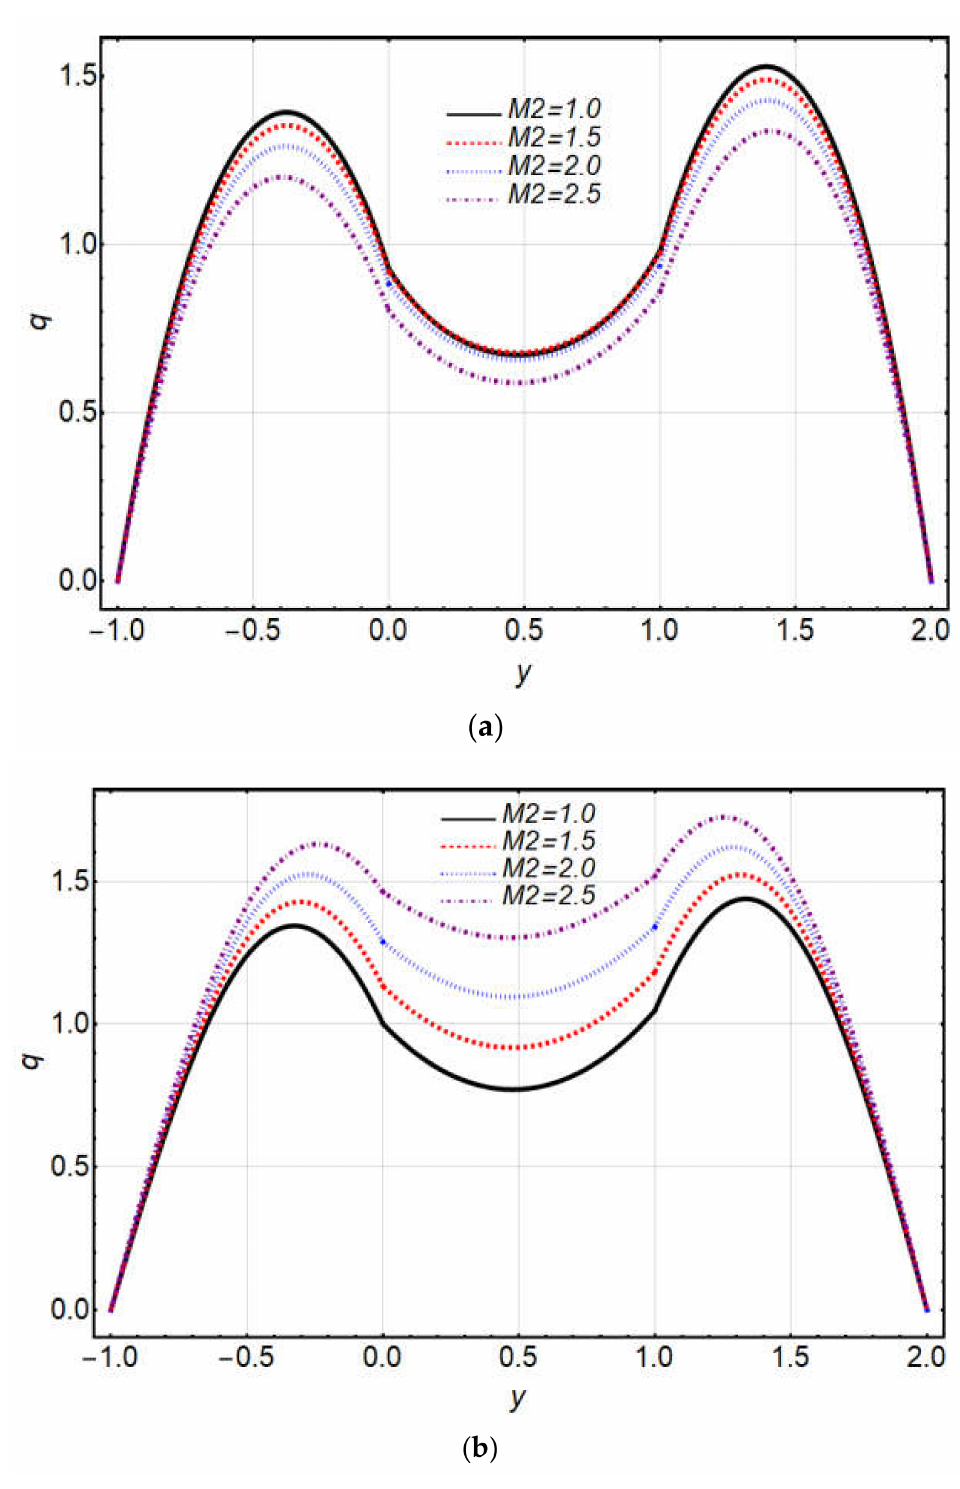
Figure 10. Velocity distribution of M 2 : ( a ) axial, ( b )